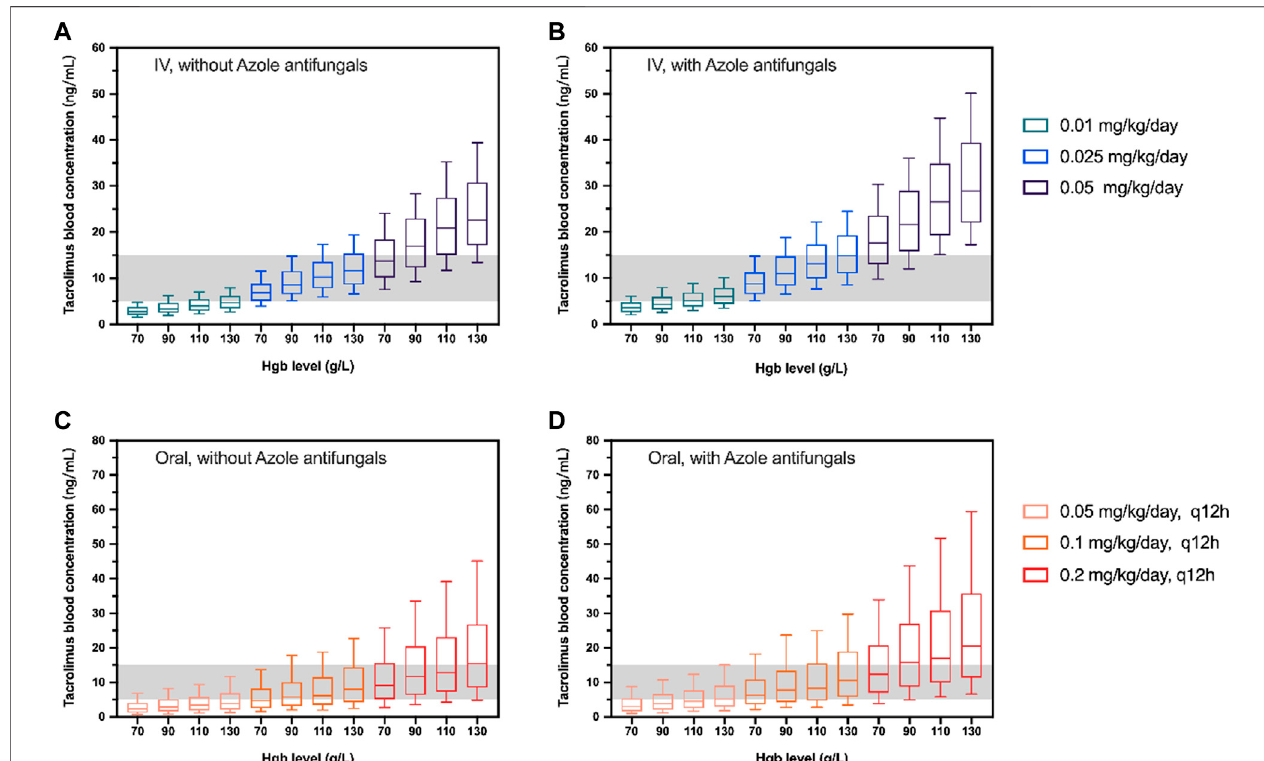
FIGURE 3 | Box plots of simulated trough concentration of the typical patient (body weight 17.4 kg) with different Hgb levels following intravenous administration (IV; (A, B) ) and oral administration (Oral; (C, D) ). The simulated dosages for intravenous infusion were 0.01, 0.025, and 0.05 mg/kg/day and 0.05, 0.01, and 0.2 mg/kg/ day(q12h)fororaladministrationwith (B,D) andwithoutazoleantifungals (A,C) .Theshadowrepresentstacrolimusconcentrationswith5 – 15 ng/mL.Thehorizontalbars in the middle are the median values and the whiskers represent the 90% percentiles of C 0 .